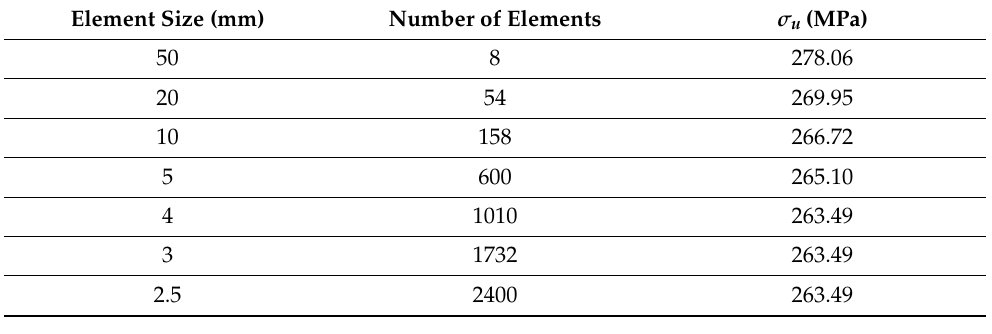
Table 4. Mesh convergence test for the verification of the computational model by Shanmugam et al. [26].